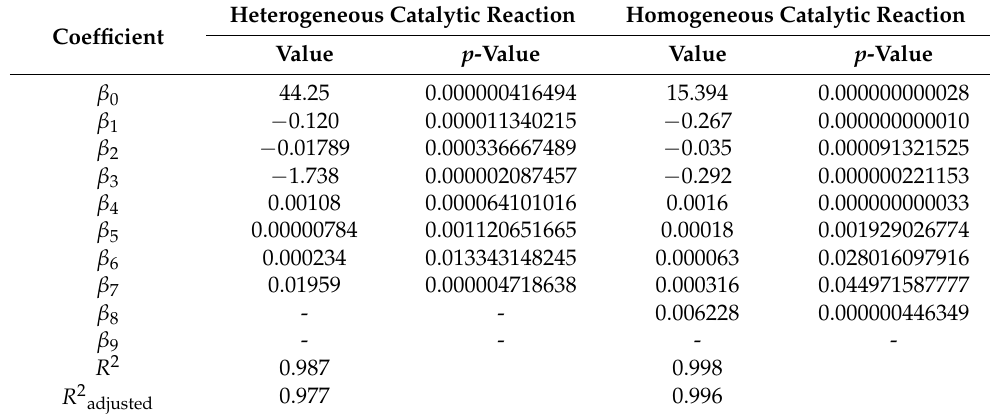
Table 3. Coefficients of the predictive